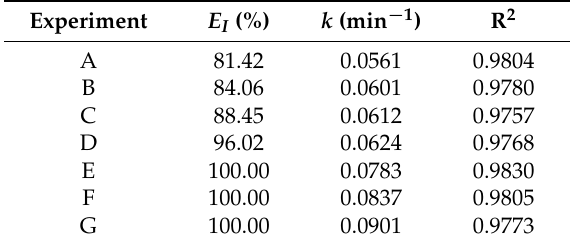
Table 3. The summary of leaching parameter for Au leaching test using Equation (1).